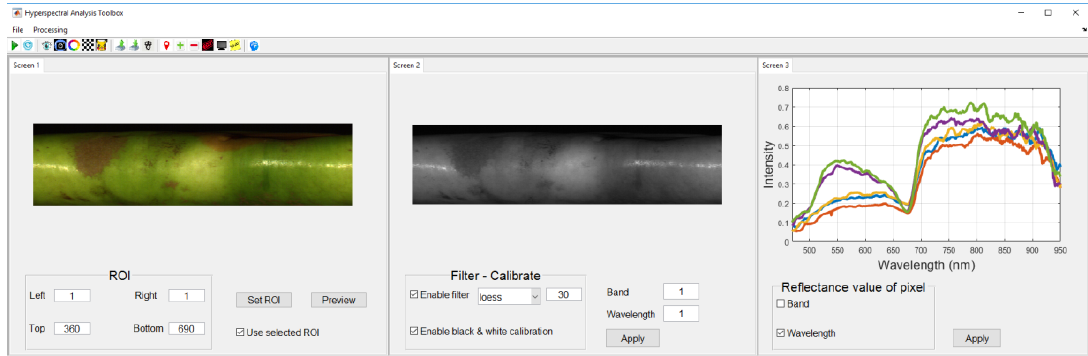
Figure 3. The graphic user interface for pre-processing hyperspectral image data of jujube specimens.